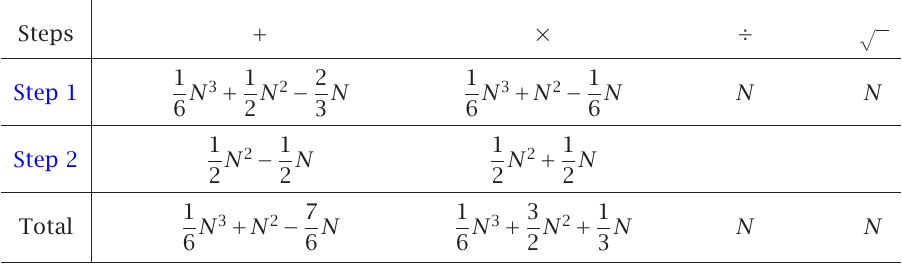
Table 2.1 . Operations counts for elimination-variant serial Cholesky.